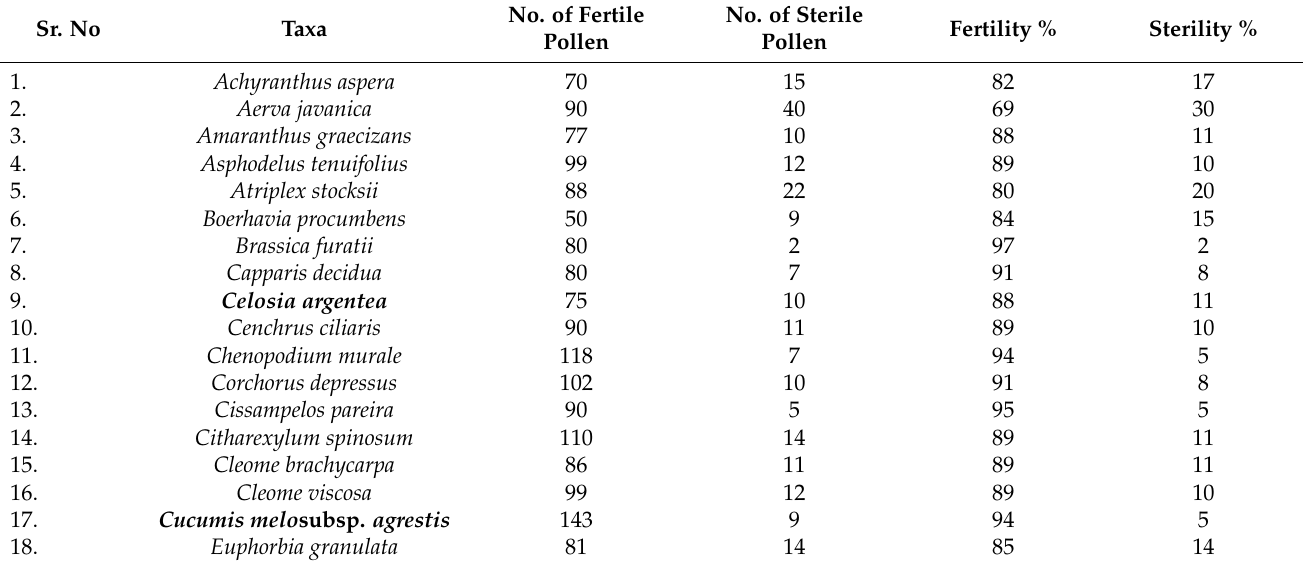
Table 4. Pollen Fertility and Sterility percentages of examined taxa.